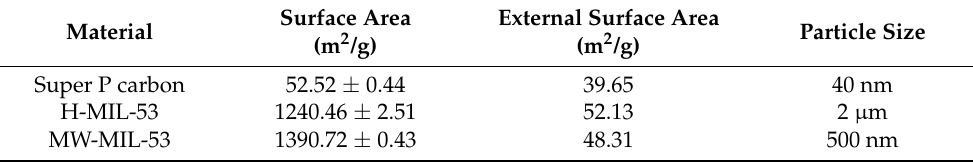
Table 1. Surface area and particle size of Super P carbon and both MIL-53 materials. The particle size of H-MIL-53 and MW-MIL-53 was evaluated using SEM